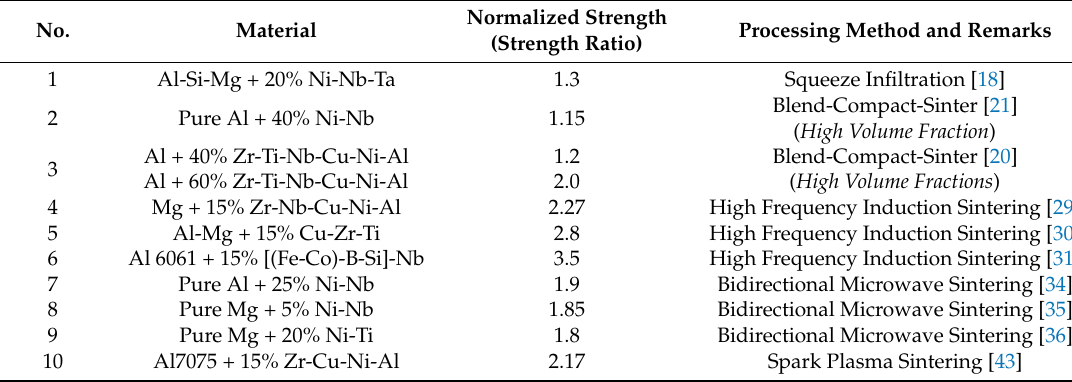
Comparison of compressive properties (in terms of normalized strength) of